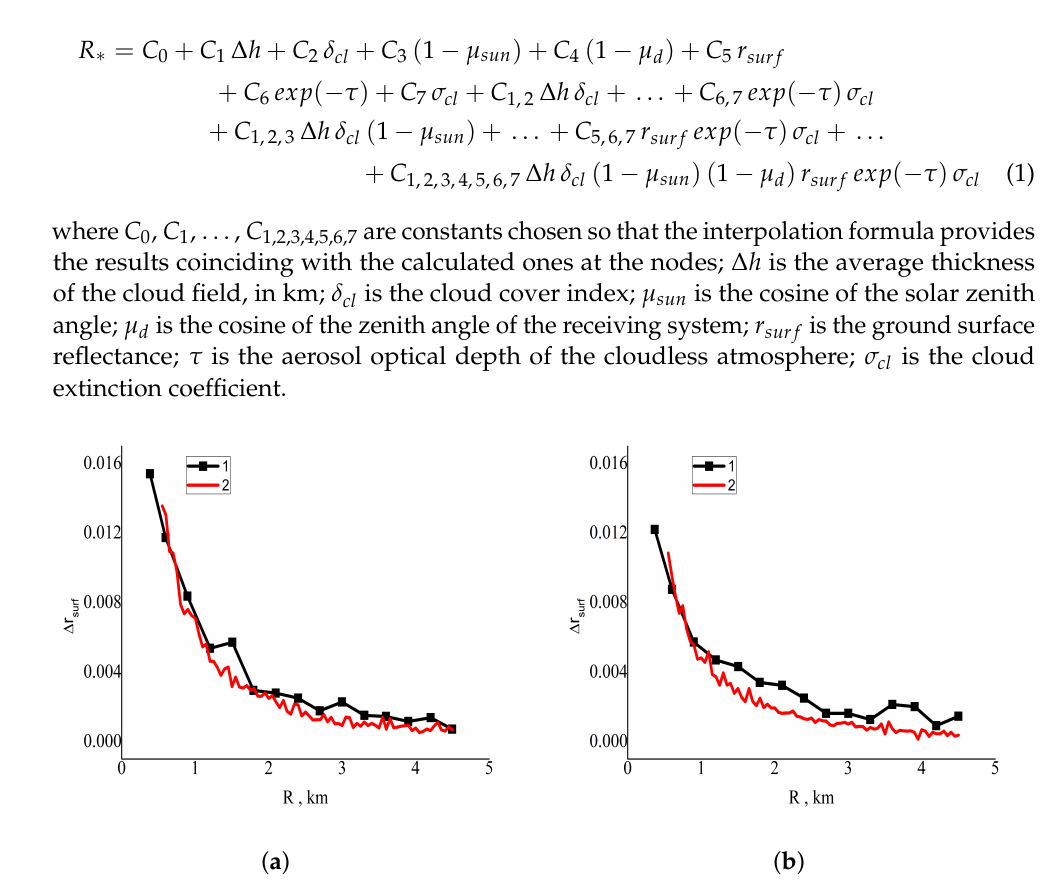
Figure 2. Test comparison of the reflectance differences ∆ r surf caused by a single cloud as functions of the distance to the cloud R : (1) results of [9] and (2) results of our program. ( a ) Observed points are located along the axis Ox on the sunward side; ( b ) observed points are located along the axis